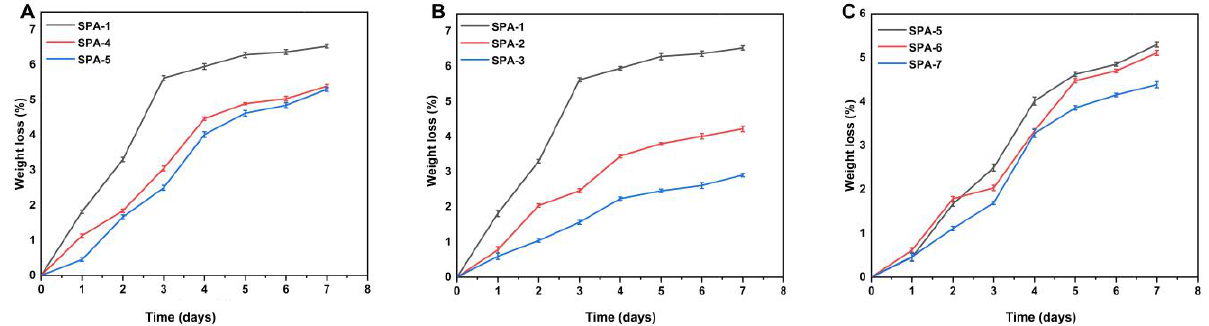
Figure 5. Effect of ( A ) sodium alginate (SPA-1,4,5), ( B ) EGDMA (SPA-1 to 3), and ( C ) PVA (SPA-5 to 7) on biodegradation of hydrogel membranes.